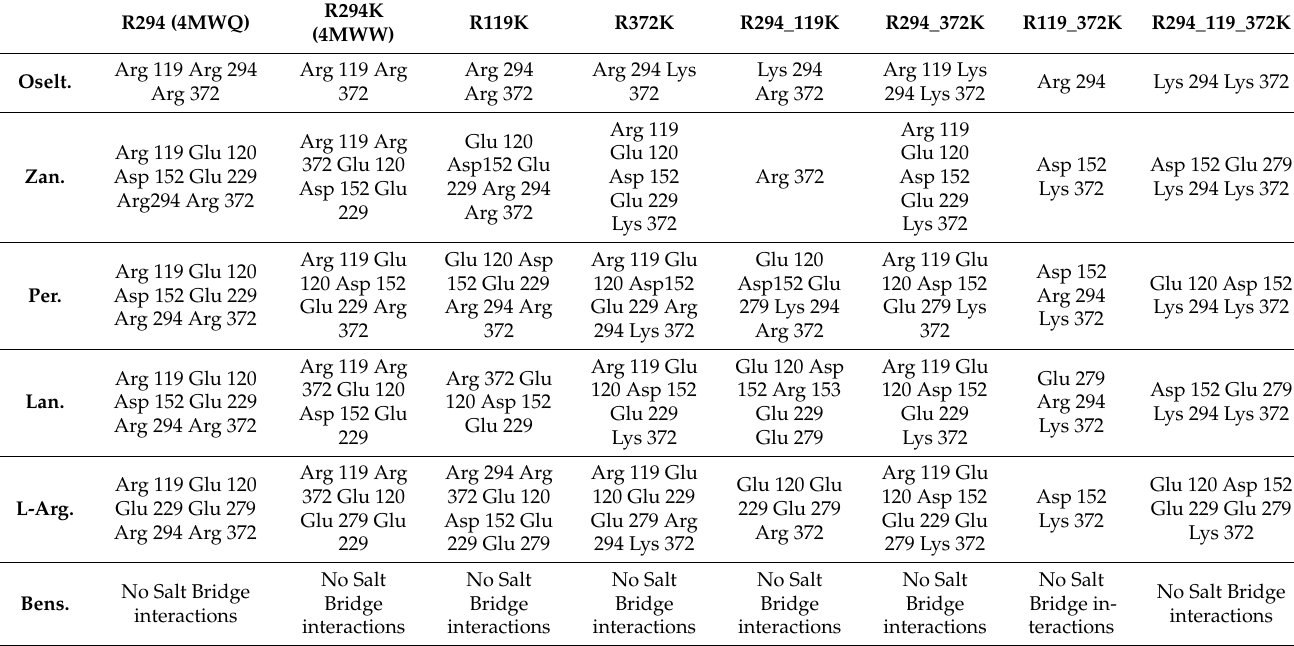
Table 5. Salt bridge interactions 1